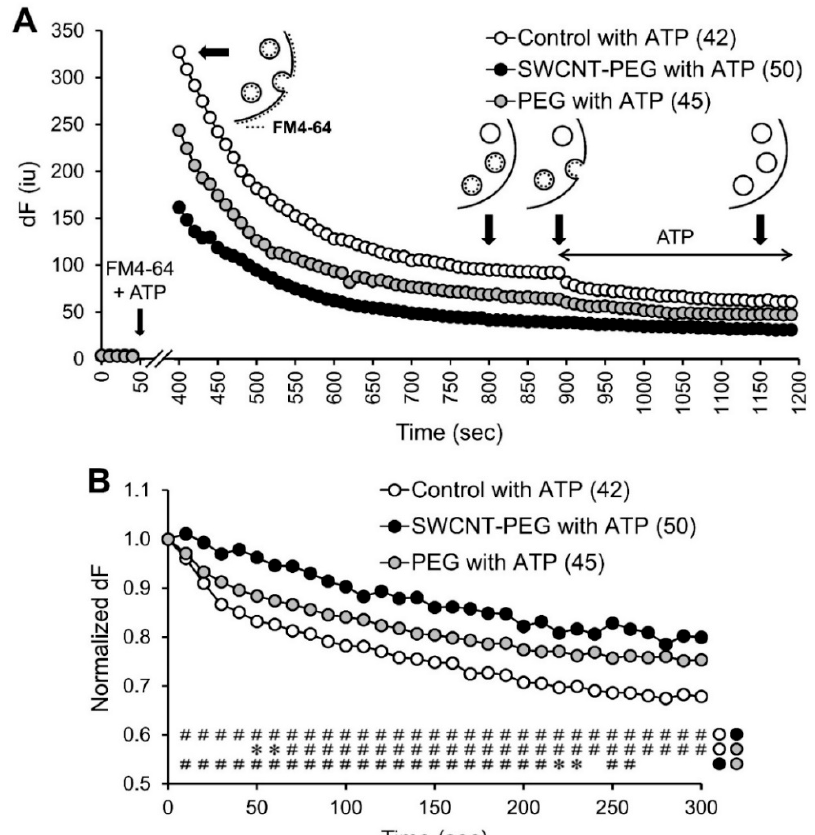
Figure 4. SWCNT-PEG solute inhibits the ATP-stimulated exocytosis (chase) of the FM4-64 pre-loaded in exocytosis vesicles by ATP-stimulation (pulse) of cultured mouse cortical astrocytes. ( A ) Time-lapse imaging of FM4-64 fluorescence for astrocyte groups stimulated with ATP once and washed as described in Figure 3 (pulse), followed by second ATP (100 μ M) application to stimulate the exocytosis of FM4-64 loaded in the vesicles (chase), the time of addition of which is indicated by the horizontal double-headed arrow. Other annotations as in Figure 3. Number of astrocytes studied in each condition is shown in parentheses and represents a fraction of the astrocytes already reported in Figure 3 but here stimulated again with ATP for the second time. The schematics show FM4-64 labeling and membrane recycling in astrocytes after dye application, at steady state after the dye washout, ATP-stimulated exocytosis and at steady state after ATP-stimulated dye washout, respectively (left to right), the time points of which are marked by the bold arrows. ( B ) FM4-64 fluorescence normalized to the steady-state level just prior to the second application of ATP. Traces in ( A ) and ( B ) show medians. Asterisks and pound signs indicate a statistical difference between the groups indicated on the right at the specific time points. KWA followed by Dunn’s test; * p < 0.05, # p < 0.01.